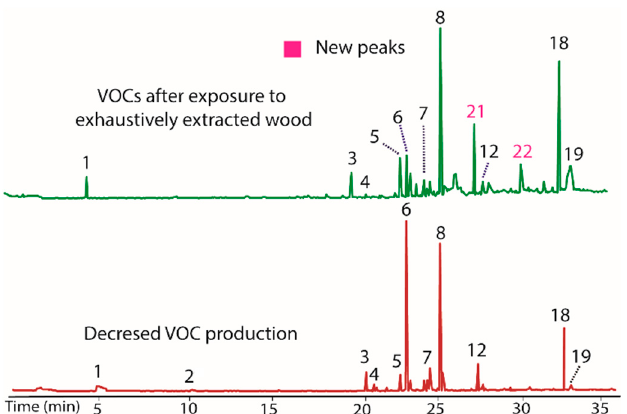
Figure 5. Chromatograms showing the influence on VOC production ( top ) of the addition of exhaustively extracted woody tissue of T. distichum to growth media (PDB). Peaks 5 and 18 increased, while 7 and 12 decreased versus BS15 after prolonged in vitro growth ( bottom ). Peaks 21 and 22 appeared as prominent components in the top plot, supporting the contention that these peaks were induced by cellulose containing materials.